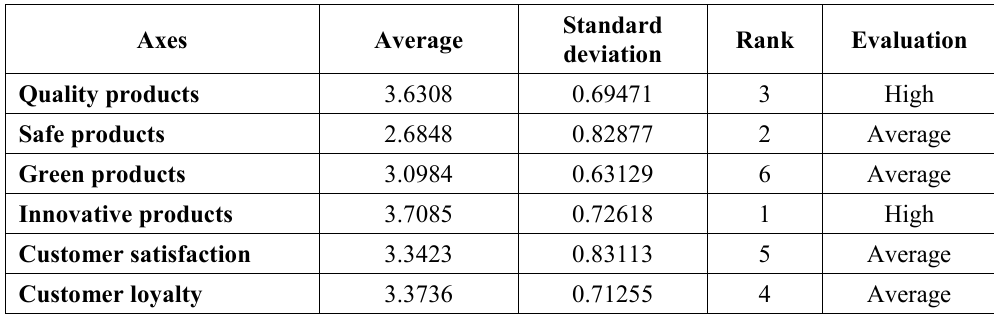
Table 2. Descriptive Statistics of Axes